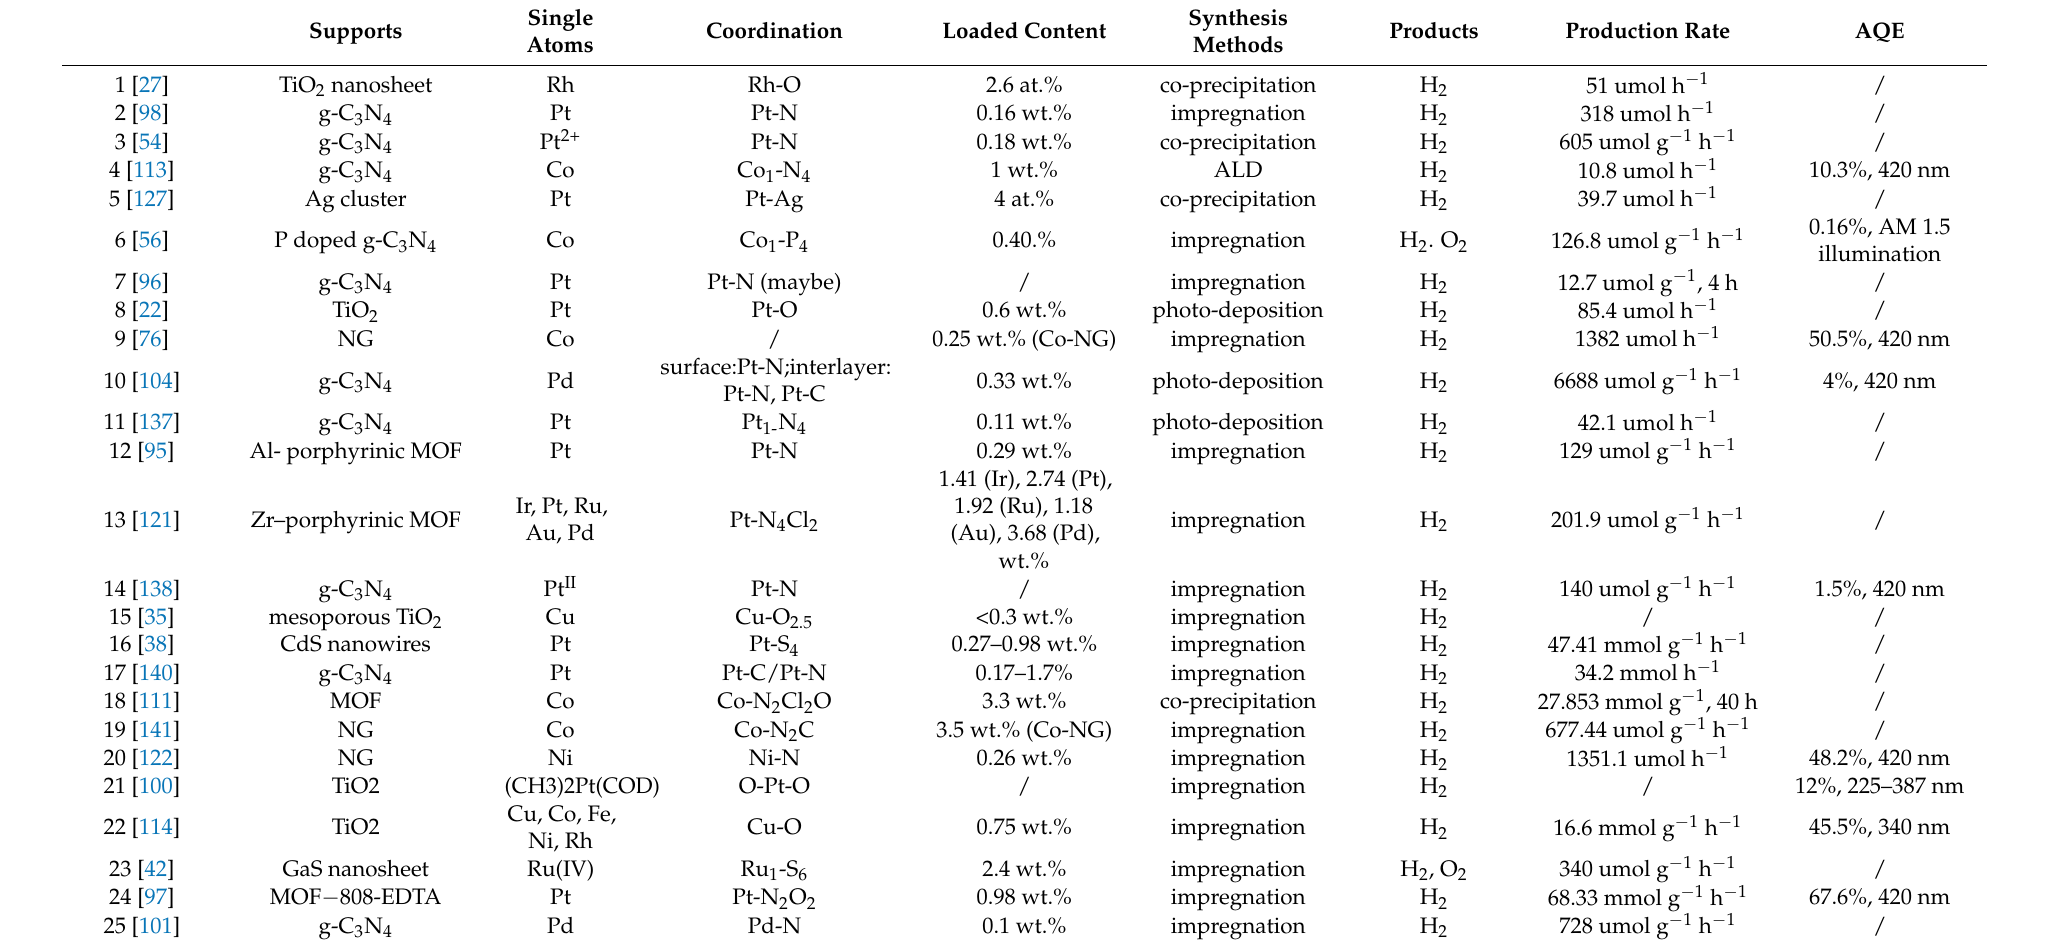
Table 1. Summary of SAPCs for photocatalytic water splitting. The order is arranged by the time of publication. Single Supports Coordination Loaded Content Atoms